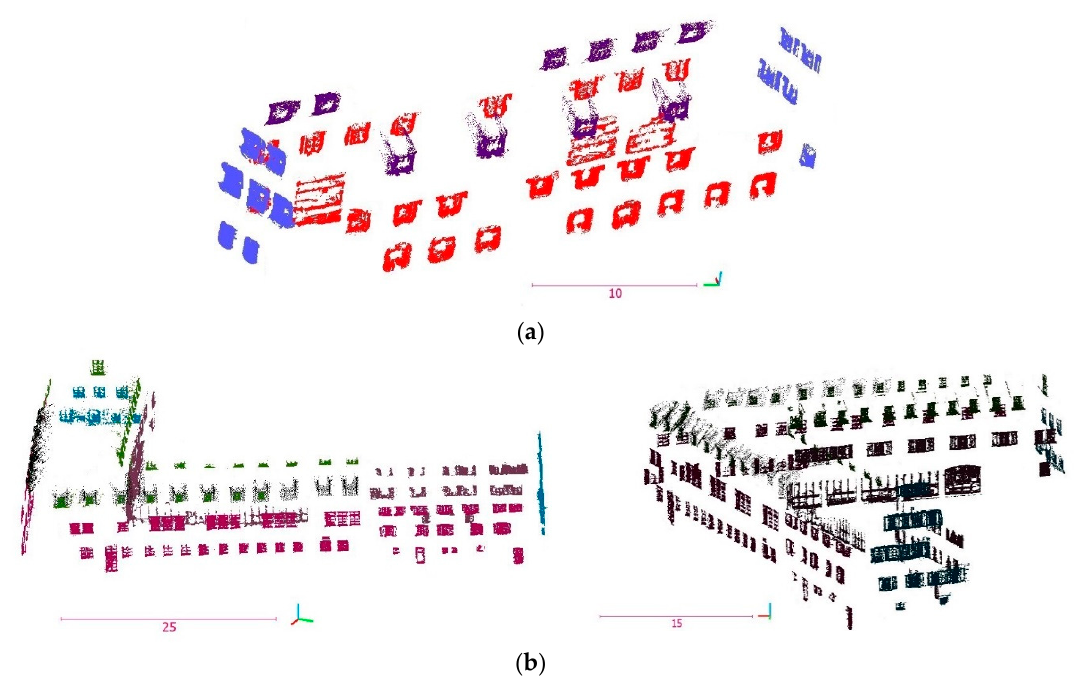
Figure 19. The extracted window patches via the difference of normal vectors (DoN) method on ( a ) the dataset 1 with radiuses of (0.2, 2)m, (0.4,3)m, (0.6,6)m and ( b ) the dataset 2 with radiuses of (0.1,1)m, (0.2,2)m, (0.25,1.5)m, and (0.8,7)m.